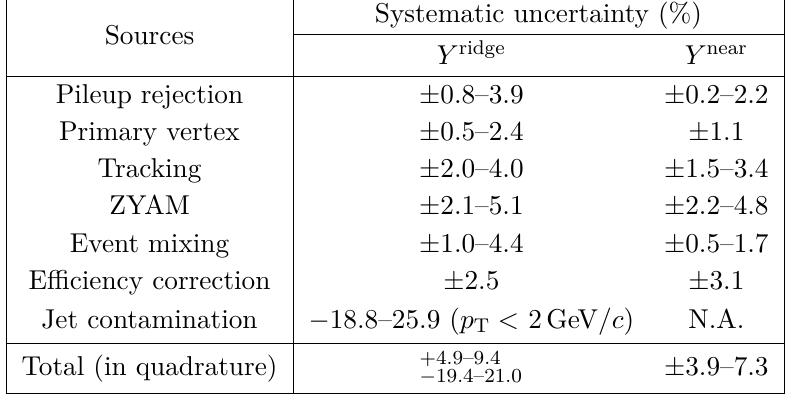
Table 1 . The relative systematic uncertainty of Y ridge and Y near . Numbers given in ranges correspond to minimum and maximum